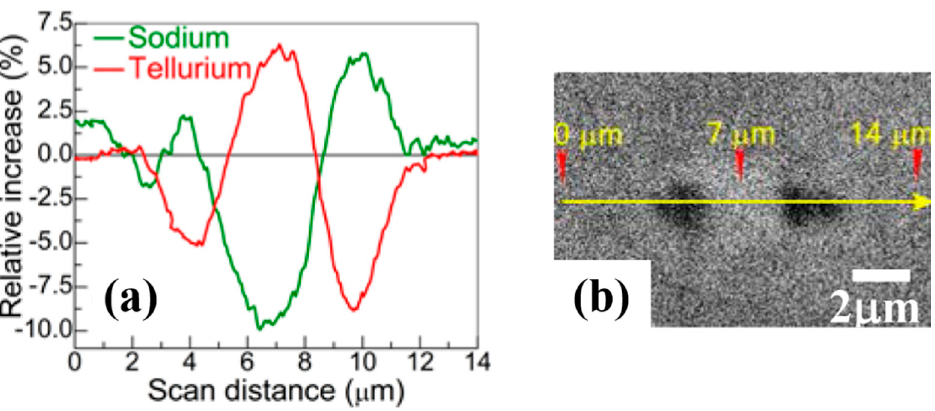
Figure 10. Line scans showing ion migration in 50TeO2-20P2O5-20Na2O-5ZnO-5ZnF2 ( λ = 1040 nm, 400-fs, 39 nJ) ( a ) and the corresponding secondary electron image. ( b ) Modified from [94]: Copyrights OSA 2014.